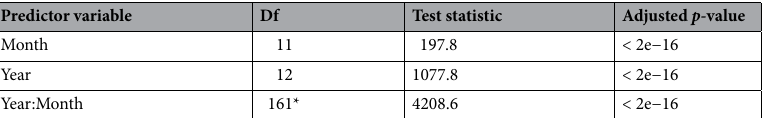
Table 2. Assessing the likelihood of an effect on the number of Chagos songs per day at site DGS (n = 5557 days). Test statistics and p -values obtained via type 1 ANOVA likelihood ratio tests from a negative binomial, generalized additive model. p -values have also been adjusted to account for multiple hypothesis testing using the Holm adjustment 45 . *Degrees of freedom are smaller than expected due to some years (n = 4) having missing